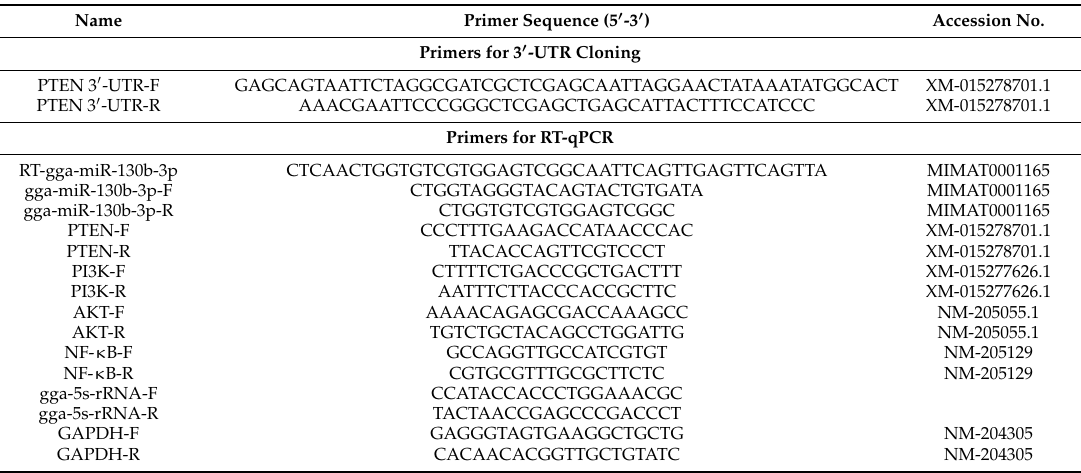
Table 1. Sequences of DNA primers.